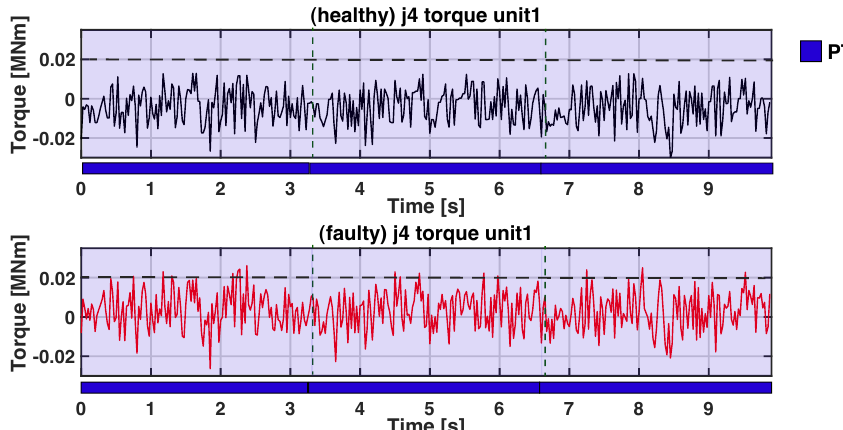
Figure 13. Data unit 1 extraction. In this Figure, three subsequential joint torque units are represented which were extracted with the label “PTP(1)” from the acquisition of 2750 sample at 40 Hz. In black and in red, respectively, the 4th joint torque is under healthy and faulty conditions.